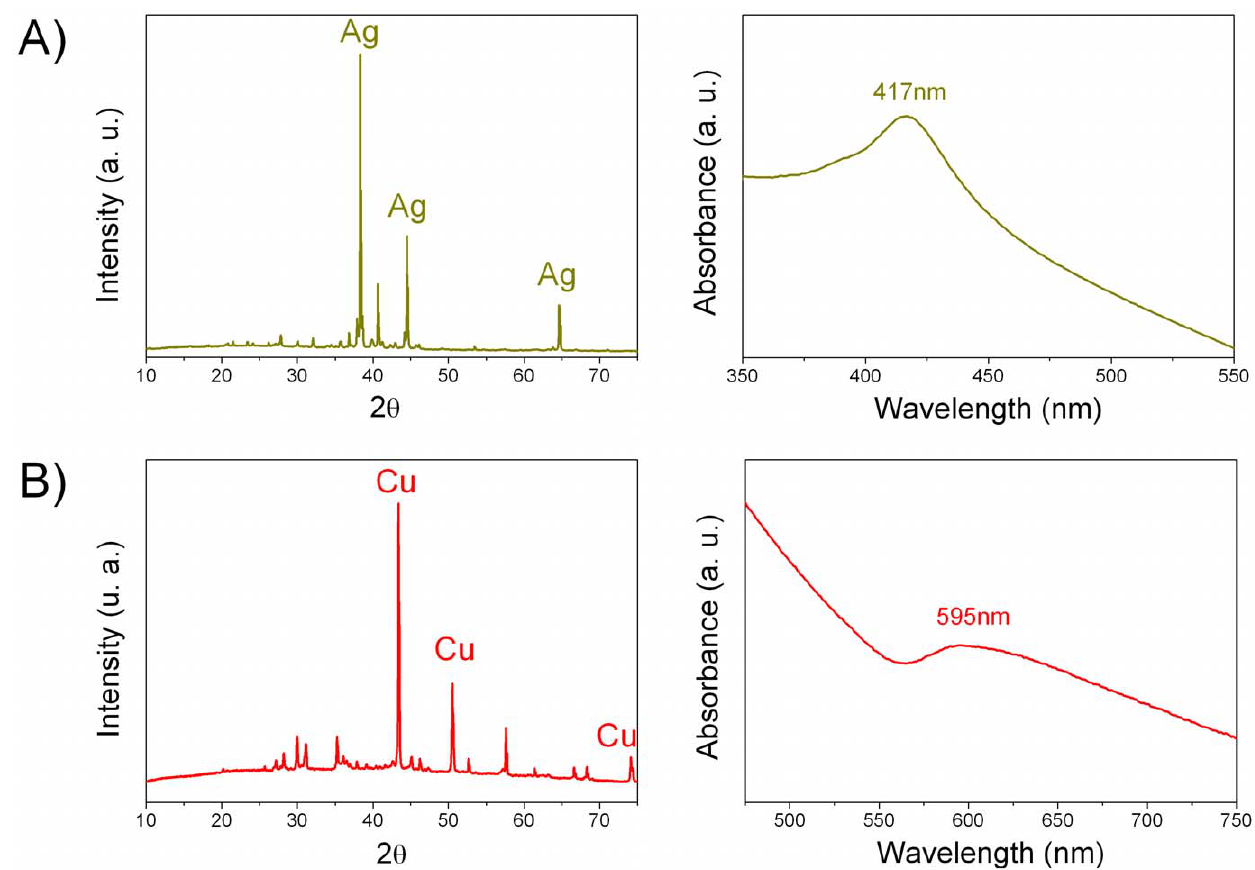
Figure 2. XRD patterns and UV-vis spectra corresponding to: A) n-Ag glass coating obtained at 740 6 C and B) n-Cu coating obtained at 850 6 C.